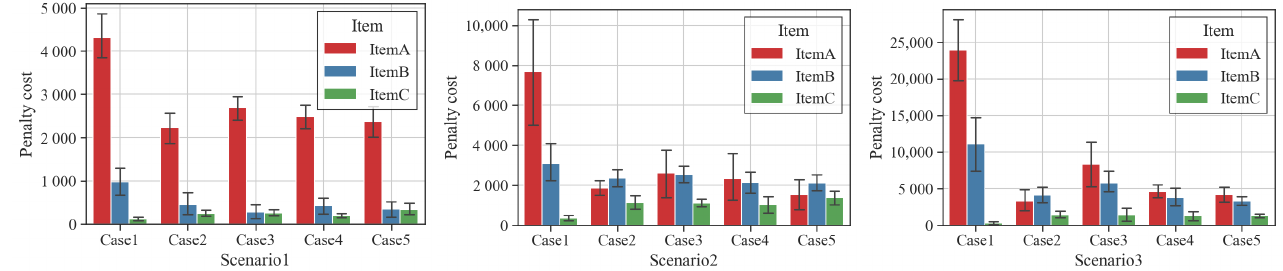
Figure 11. Penalty cost for each item in each scenario. The values are averages of 10 training trials, and the error bars represent 95% confidence intervals.